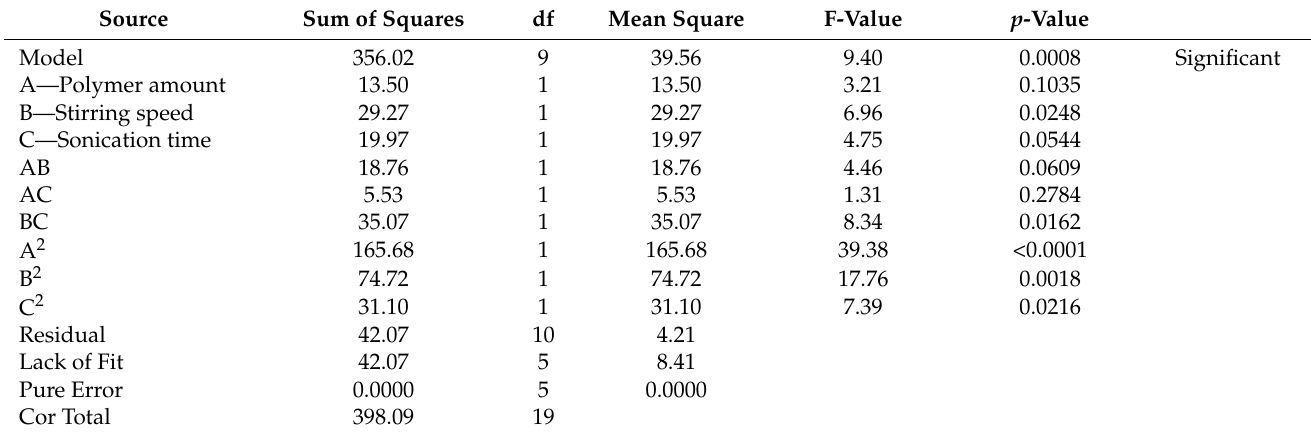
Table 2. Analysis of variance (ANOVA) for factorial model at p < 0.05 level of